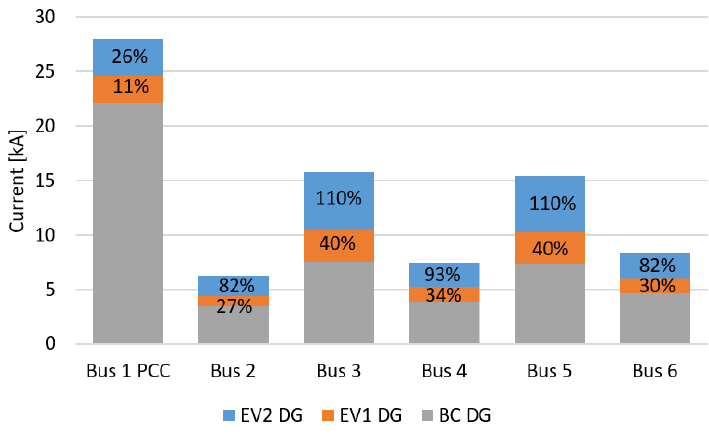
Figure 8. Short-circuit scenarios with DG.